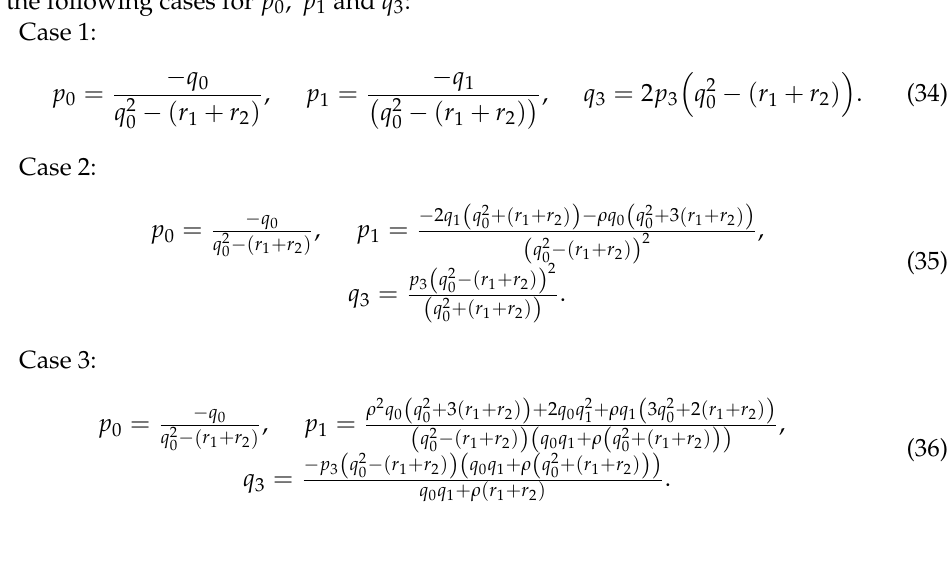
Figure 2. The 3D plots of the real and imaginary parts of 𝑟𝑟 1 = 𝑟𝑟 2 = 1, 𝑘𝑘 1 = 𝑘𝑘 2 = 1, 𝑞𝑞 0 = 0.2, 𝑝𝑝 2 = − 1, 𝑞𝑞 3 = 0.5 Family II: When 𝑝𝑝 2 = 𝑞𝑞 2 = 0 , let 𝑞𝑞 0 , 𝑝𝑝 3 , 𝑞𝑞 1 , 𝑟𝑟 1 and 𝑟𝑟 2 be arbitrary constants. Then, we get the following cases for 𝑝𝑝 0 , 𝑝𝑝 1 and 𝑞𝑞 3 :